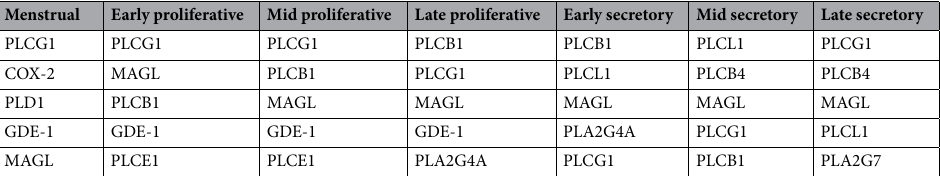
Table 1. List of 5 most expressed genes across the menstrual cycle. 5 highly expressed genes for each of the 7 menstrual stages with the most expressed gene at the top. The majority of the genes listed encode for synthesising enzymes of the endocannabinoid system with two exceptions of COX-2 and MAGL which encode for degrading enzymes.